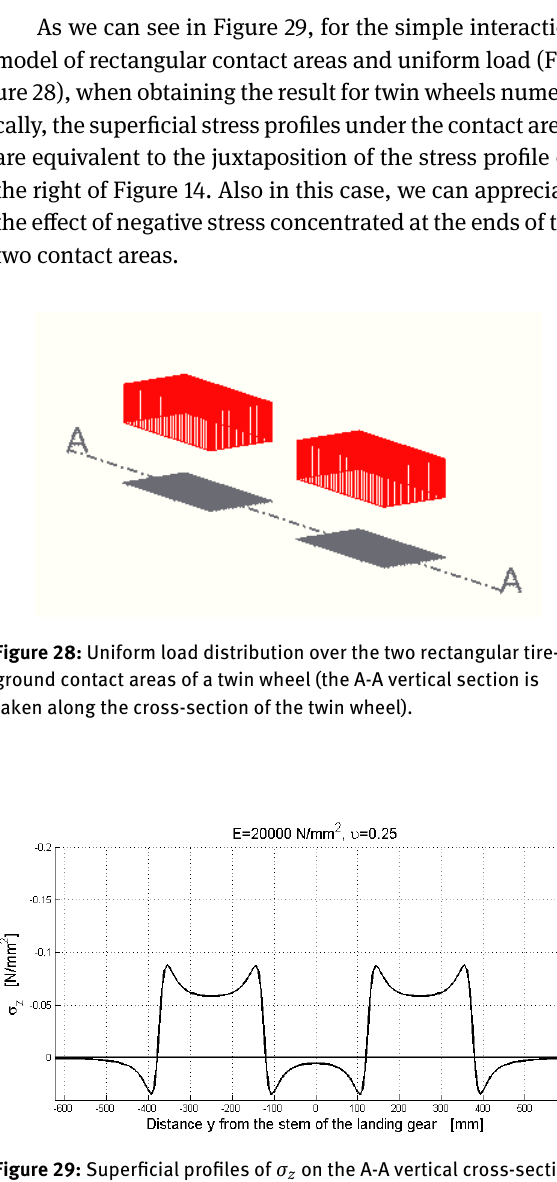
Figure 29: Superficial profiles of σ z on the A-A vertical cross-section of Figure 28, according to the second order